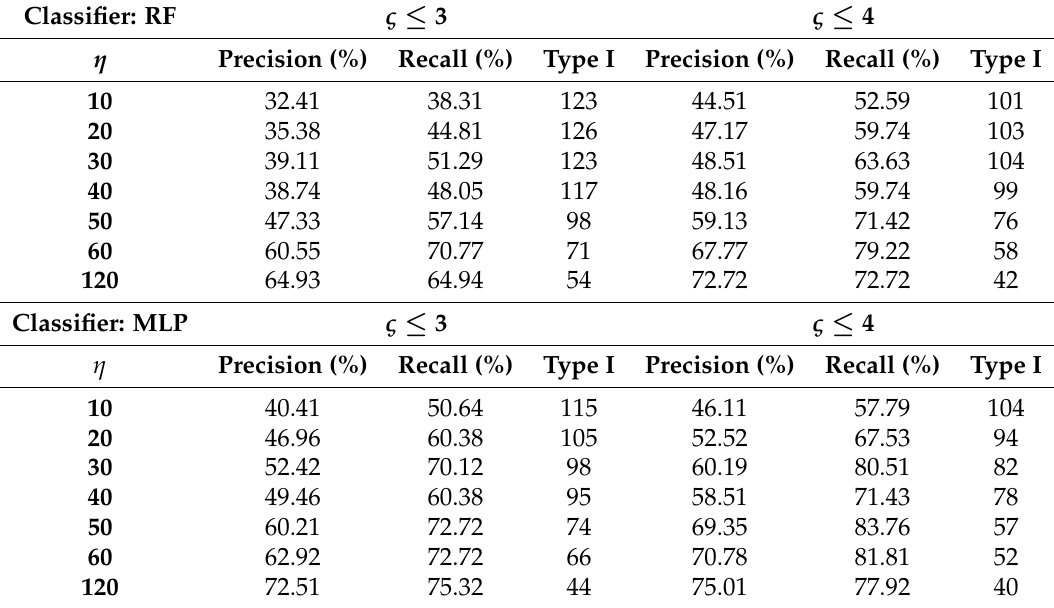
Table 9. Context 1, Scenario 2: Trip detection accuracy by RF and MLP based classifiers using GPS and spatial